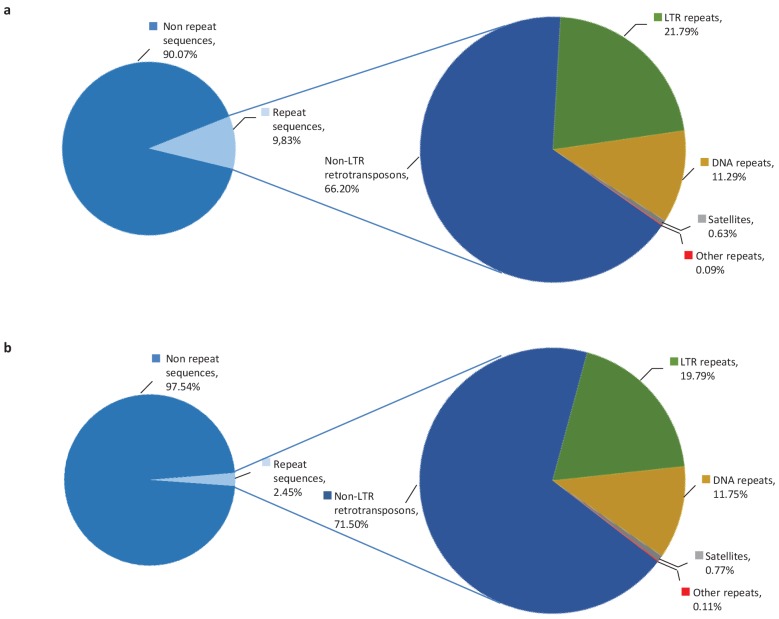
10% of altORFs are present in different classes of repeats.While more than half of the human genome is composed of repeated sequences, only 9.83% or 18,003 altORFs are located inside these repeats (a), compared to 2,45% or 1,677 CDSs (b). AltORFs and CDSs are detected in non-LTR retrotransposons (LINEs, SINEs, SINE-VNTR-Alus), LTR repeats, DNA repeats, satellites and other repeats. Proportions were determined using RepeatMasker (version 3.3.0).10.7554/eLife.27860.005Figure 1—figure supplement 1—source data 1.10% altORFs are present in different classes of repeats.